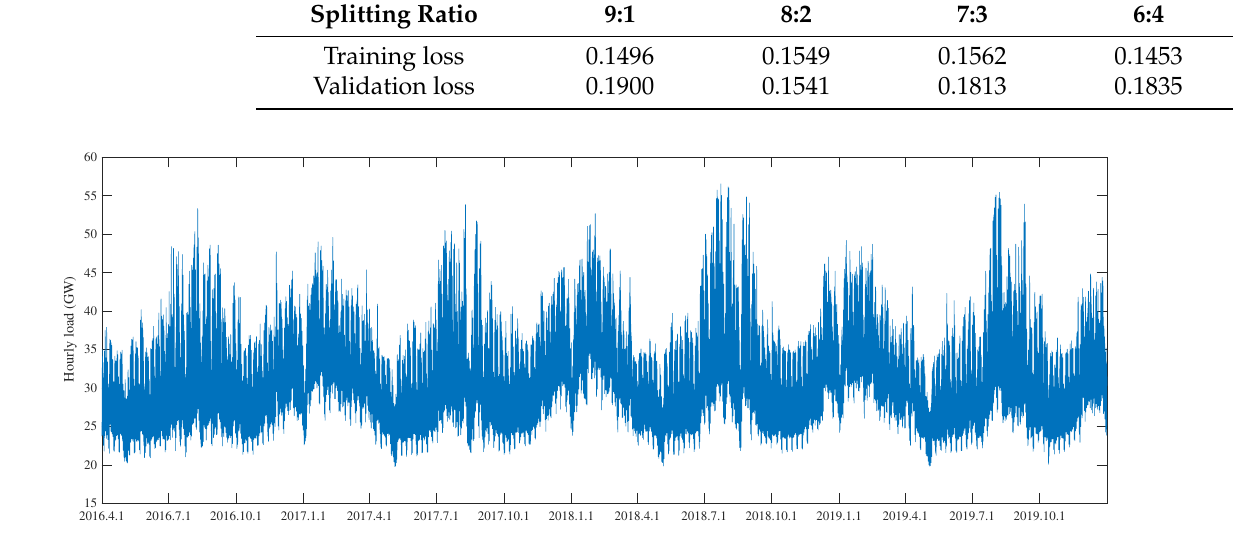
Figure 5. The hourly load